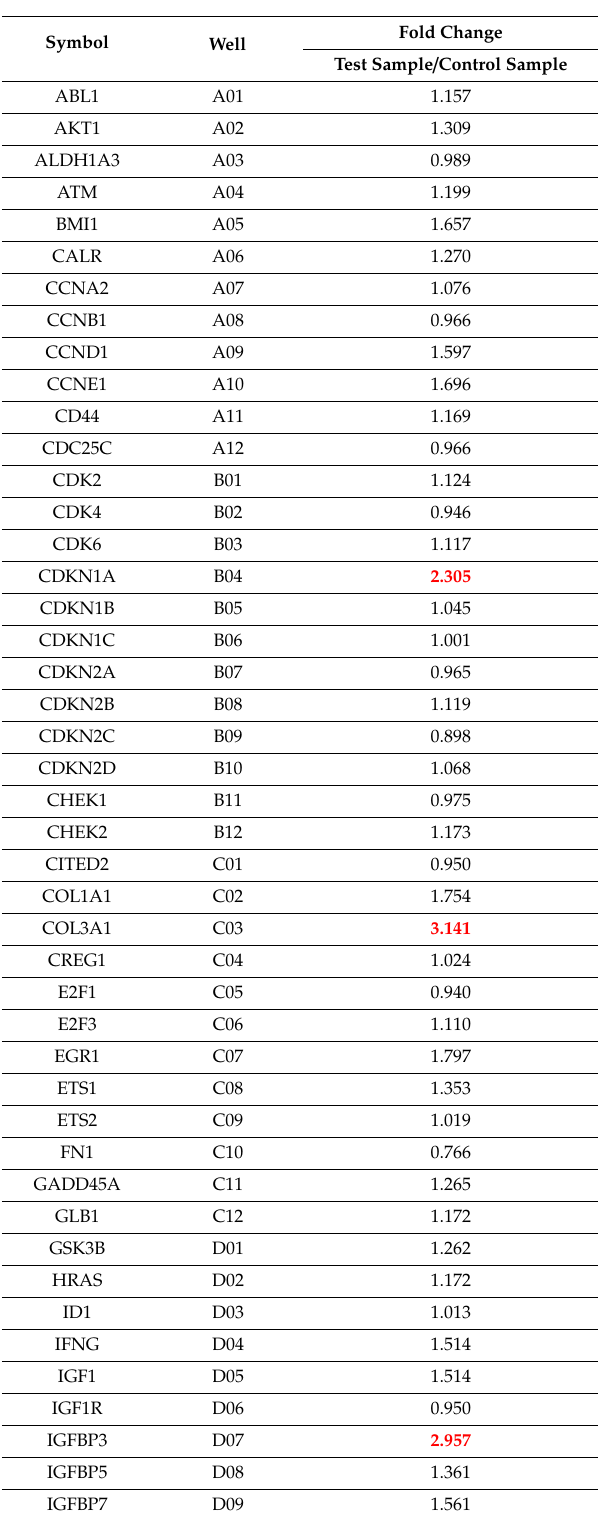
Table 1. The qPCR array profiling of senescence-related genes in HCT-116 cells upon FA treatment (1 µ g / mL). Red indicates changes greater than 2